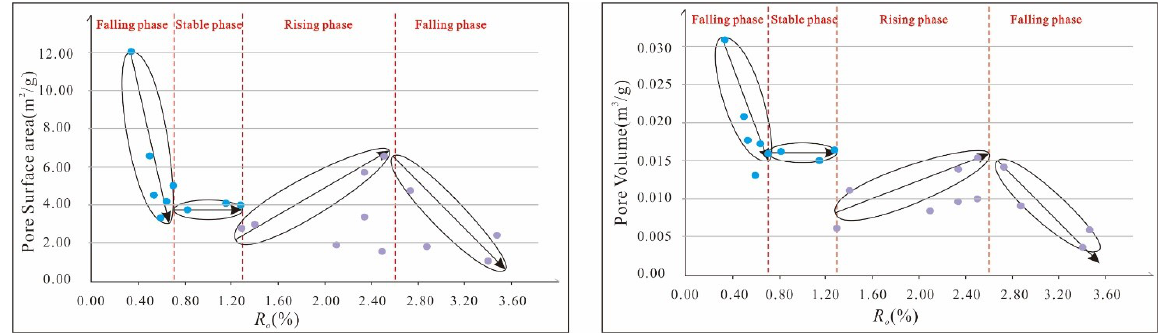
Figure 9: Characteristics of pore volume and specific surface area with maturity evolution (Ro, %) (Organic maturity 0.35-1.41 is quoted from Chen et al.